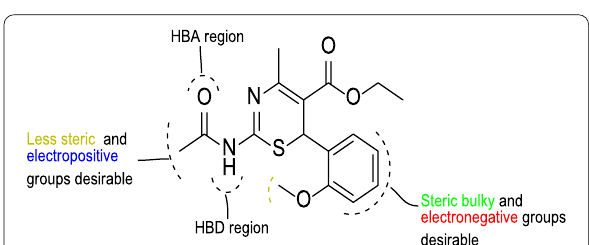
Fig. 9 General description of the 3D QSAR